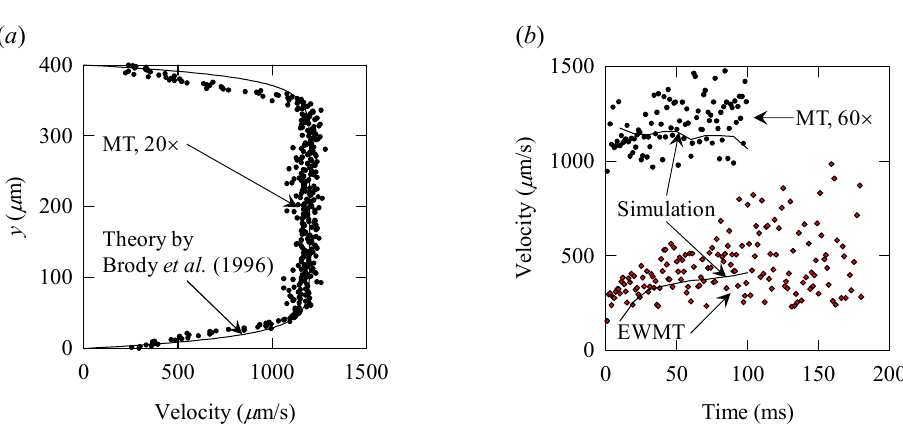
Figure 11. ( a ) Velocity profile of pressure-driven flow obtained from MT by volume illumination with the 20 × objective lens using the CMOS camera in comparison with the theoretical result by Brody et al. (16) and ( b ) the time evolution of the pressure-driven flow velocity at y = 200 µ m obtained from EWMT and MT by volume illumination with the 60 × objective lens using the CMOS camera in comparison with the numerical simulations. Measurement was performed just after 74 ms of the UV laser exposure, thus, for example, 4 ms corresponds to t = t + 4 ms ( t = 74 ms). The centerline velocity was calculated to be 0 0 1.19 × 10 3 µ